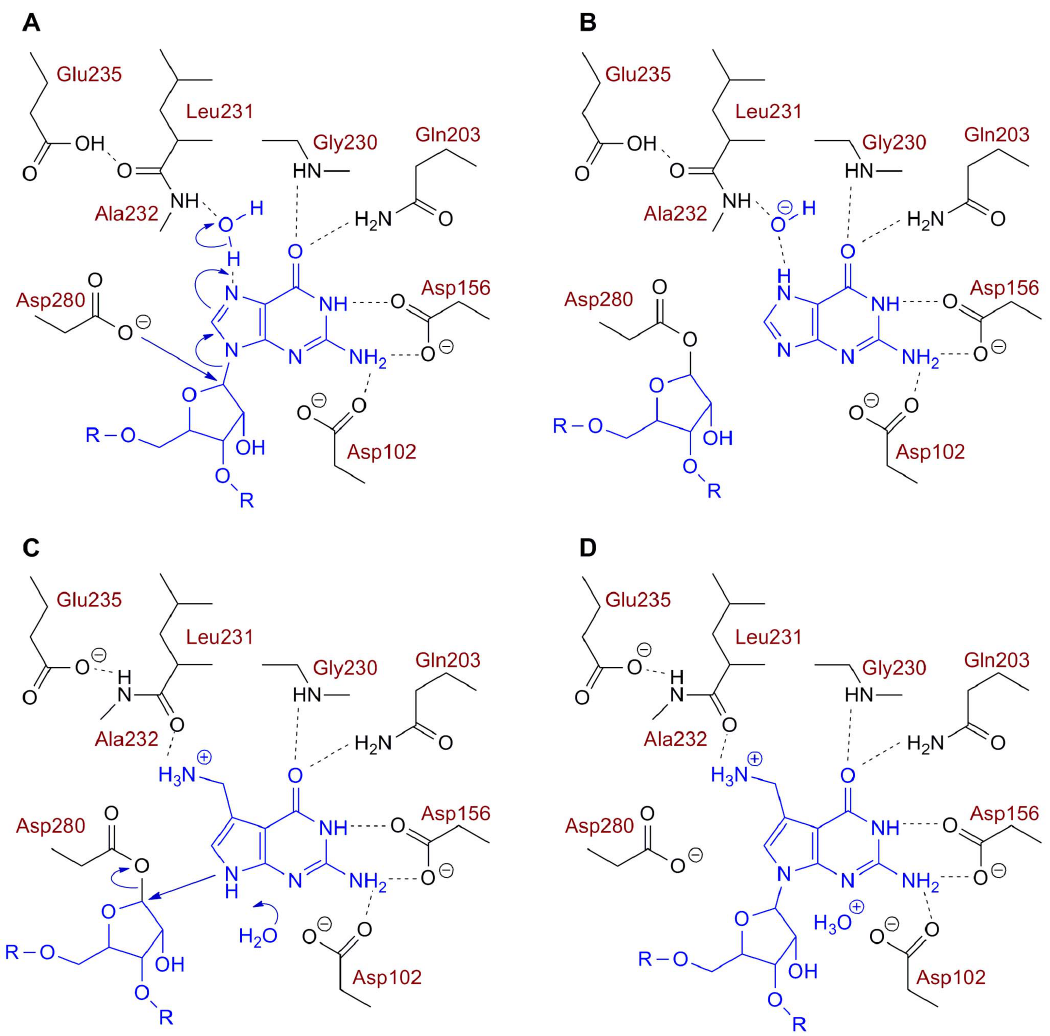
Figure 3. Assumed catalytic mechanism of bacterial Tgt. (A and B) The glycosidic bond of guanosine 34 is cleaved via nucleophilic attack by the Asp280 carboxylate resulting in the formation of a covalent Tgt ? tRNA intermediate. (C and D) Guanine is replaced by preQ 1 which is incorporated into the tRNA via nucleophilic attack of the ribose 34 anomeric carbon by N 9 of preQ 1 . Notably the replacement of guanine by preQ 1 in the binding pocket of Tgt induces a flip of the Leu231/Ala232 peptide bond. The formation of a hydroxide and an oxonium ion as byproducts of the reaction is assumed to be responsible for its irreversibility as mutual neutralisation will efficiently detract these ions from equilibrium. H -bonds are indicated by dashed